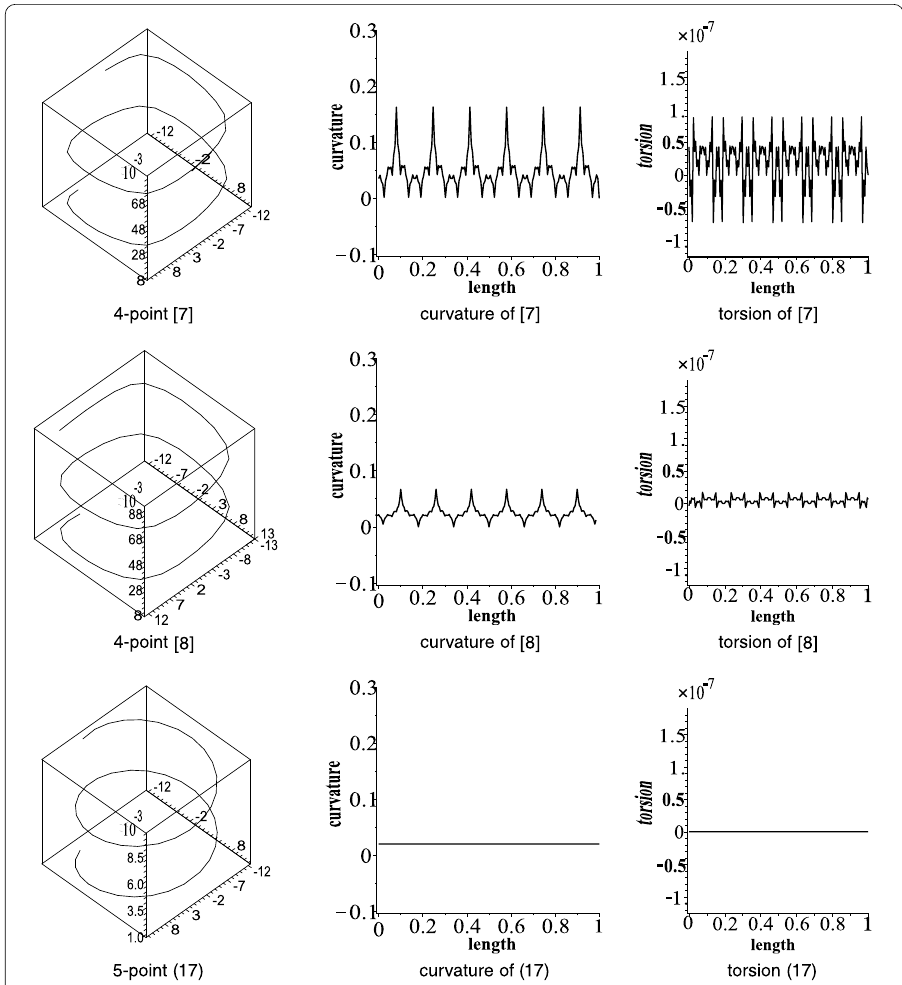
Figure 8 Results after the 5th iteration of 4-point and 5-point schemes of [8, 14], (17) are shown on the left when the initial control points are sampled from Helix. The corresponding curvature and torsion are shown in the center and right columns,